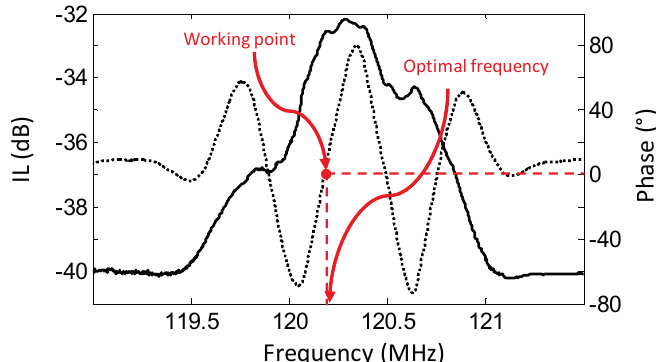
Figure 8. Frequency response of the LW sensor mounted in the fabricated flow-through cell and loaded with water. The measurement was obtained with the electronic characterization system. The solid line represents the IL loss and the dotted line represents the phase. The red spot indicates the working point that it is used for determining the optimal operation frequency of the